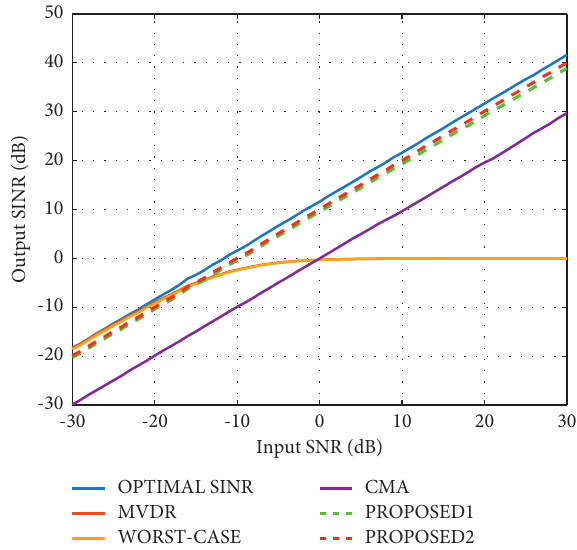
Figure 3: NA: output SINR versus the input SNR.